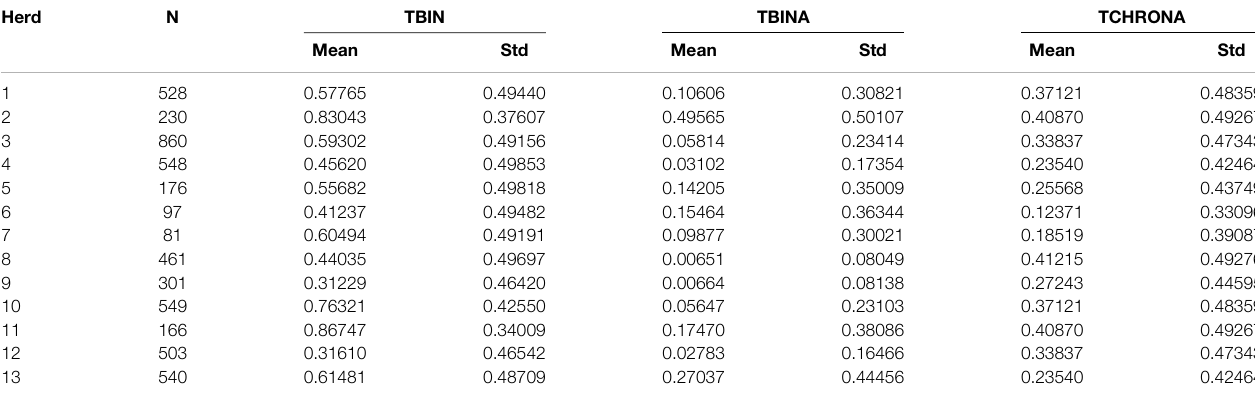
TABLE 1 | Overview of the data by herds and phenotypic trait variables.